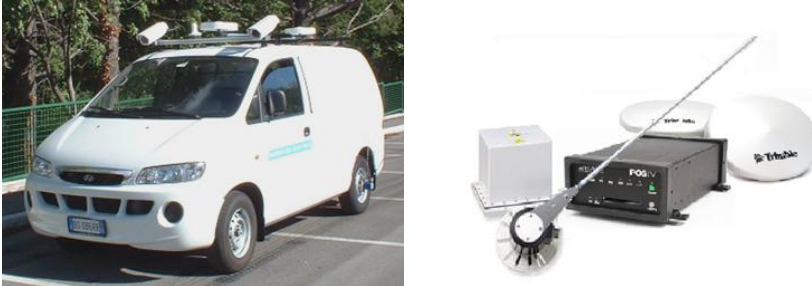
Figure 2. The MMS of the GeoSNav Lab, University of Trieste, and the Applanix Corporation POS/LV© system components mounted on board the vehicle. MMS data were used to create the reference trajectory.